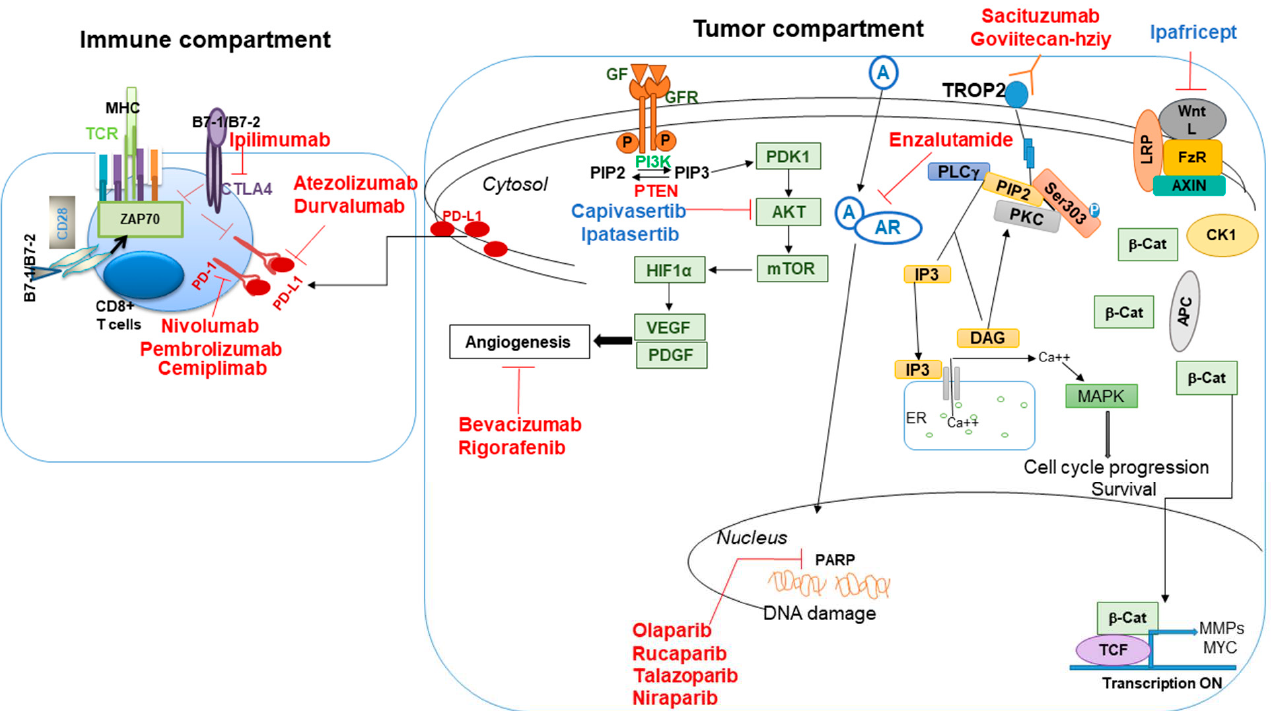
Figure 2. Targeted and immunotherapies in TNBC clinical studies. Several targeted drugs in the TNBC tumor and immune compartments have been explored either with a single agent or combinations to attack the tumor-microenvironment. Various signaling targets (including the PI3K-AKT-mTOR pathway; Wnt-beta-catenin pathway), DNA damage response pathway (targeting PARP), critical/relevant immune checkpoint pathway (PD-L1-PD-1 axis, CTLA4), angiogenic pathway (HIF1 alpha-VEGF), and ADC target (TROP2-mediated ADC) are shown. The molecular landscape of TNBC (including immune compartment) confers insight into the novel and investigational targeted therapies, which are directly confronting its heterogeneous biology, cellular signaling pathways, and their importance for targeting in TNBC tumor. This molecular landscape provides insight into the heterogeneous biology and rationale for targeted therapies. AR, androgen receptor; RED, FDA approved drugs; BLUE, FDA non-approved drugs but active in clinical trials.